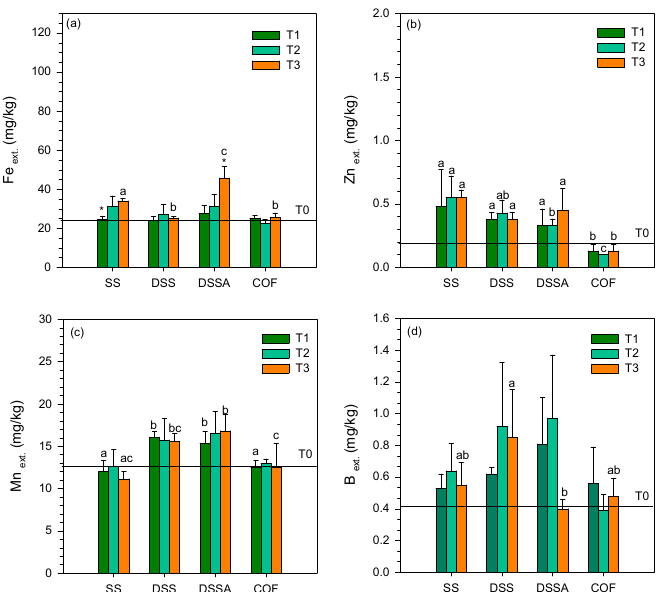
Figure 7. Micronutrients content in the soil after lettuce growth for the different soil amendments: ( a ) extractable iron; ( b ) extractable zinc; ( c ) extractable manganese; ( d ) extractable boron (T0—0 kg N/ha; T1—85 kg N/ha; T2—170 kg N/ha; T3—255 kg N/ha; mean values and standard deviations obtained in four replicates of each treatment; different letters indicate statistical differences between materials; * indicate statistical differences between treatments within each added material; the statistical analysis was conducted separately for each figure).